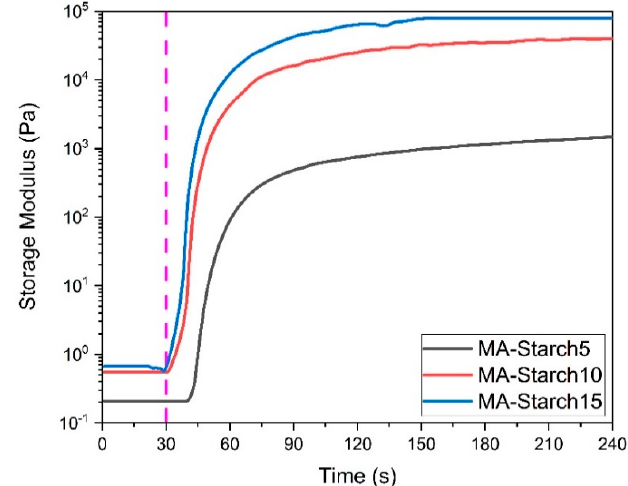
Figure 3. Photorheological evaluation: Elastic modulus G’ as a function of time for the photocurable starch formulations at different concentrations of MA-starch. The lamp was switched on after 30 s (the dashed line).